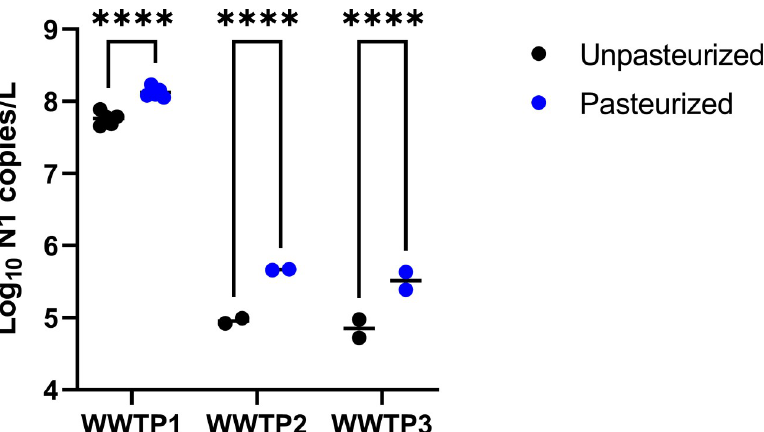
Fig 2. Effect of pasteurization: Copy number yield for the N1 target obtained from three 24-hr composite wastewater samples processed either with or without pasteurization (n = 5 for WWTP1 and 2 for WWTP 2 & 3). Each point is the mean of three technical replicate measurements. Horizontal black lines show means and asterisks show significance level in pairwise comparisons where ns = P > 0.05; � = P � 0.05; �� = P � 0.01; ��� = P � 0.001; ���� = P �